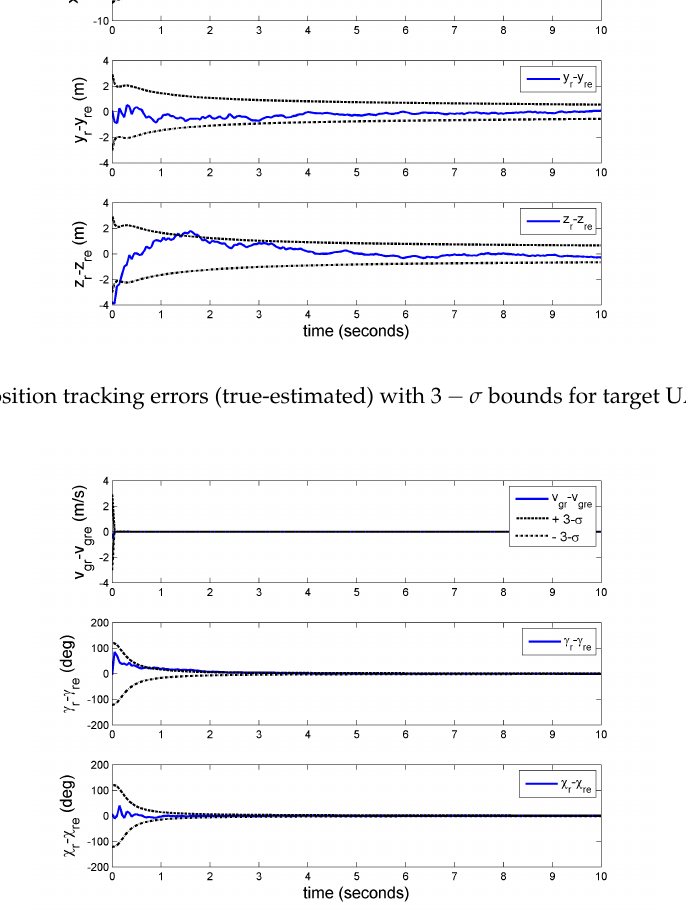
Figure 13. Speed, flight path angle, and heading angle errors (true-estimated) with 3 − σ bounds for target UAV (Case 1C).